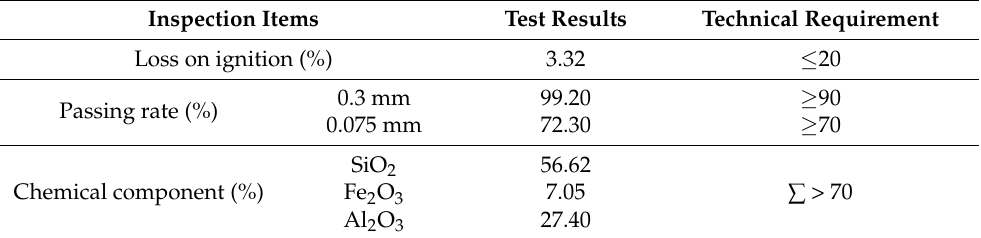
Table 3. Physical chemistry properties of fly ash.